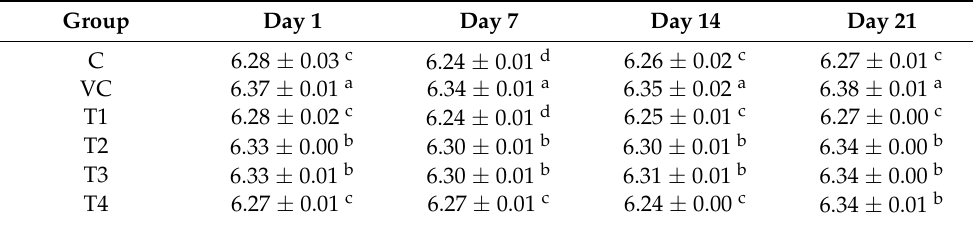
Table 4. Changes in pH of frankfurters during storage at 4 ◦ C (n = 6).